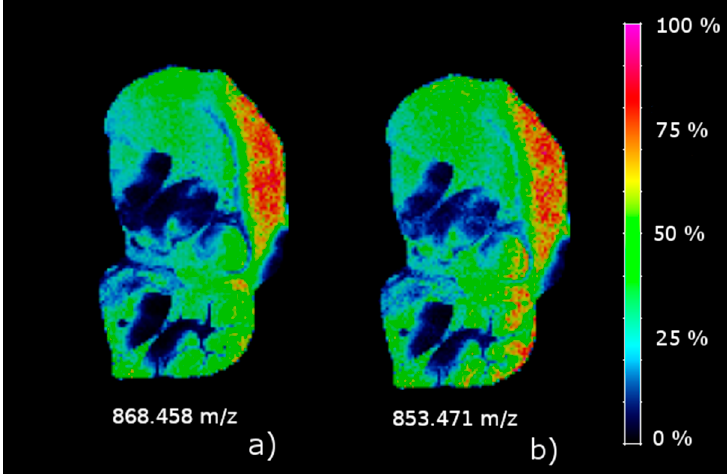
Figure 5. Concentration images of two absolutely down-regulated ions in C3. (a ) m/z 868.458; (b) m/z 853.471.